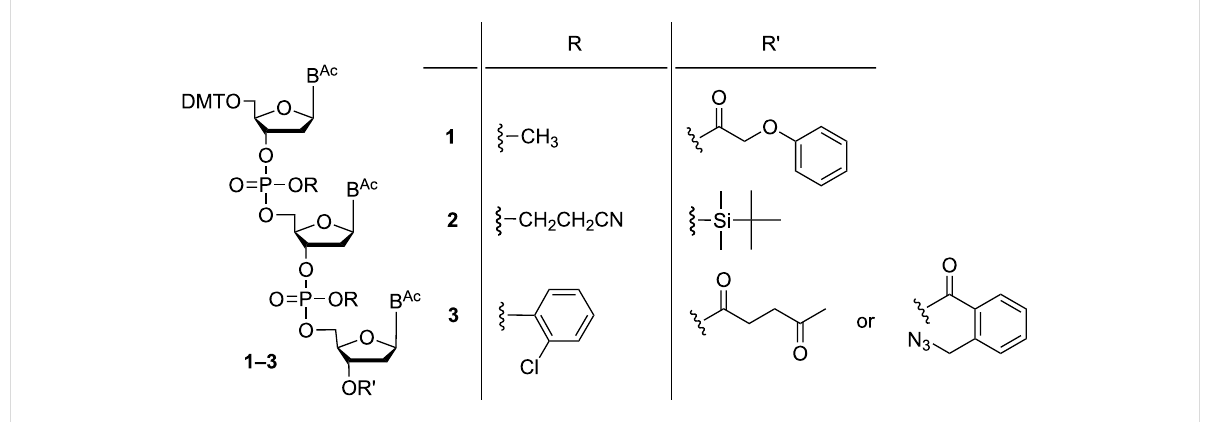
Figure 2: Strategies for trinucleotide synthesis using different pairs of orthogonal groups for protection of the phosphates and the 3'-OH-function.